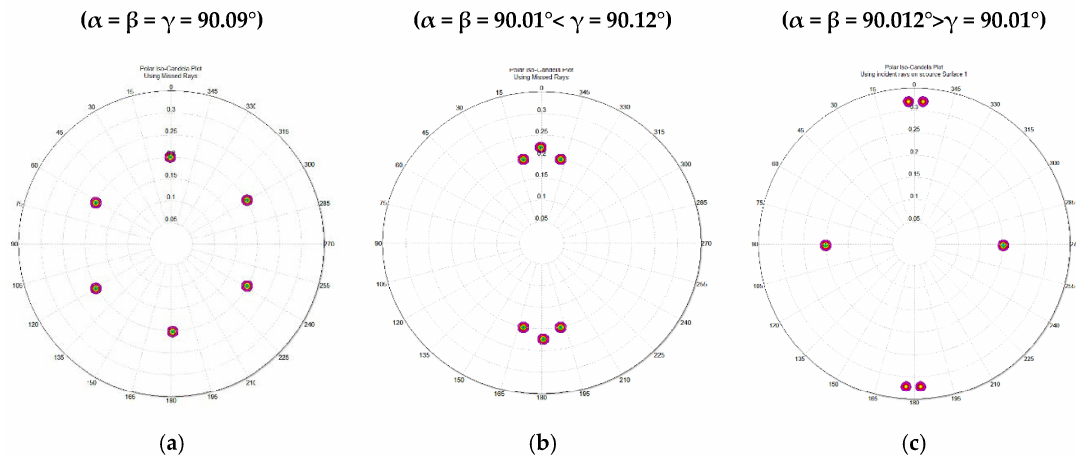
Figure 4. Relationship between dihedral angles and the reflected beam direction. ( a ) The reflected intensity distribution by a regular retro-reflector. ( b ) The reflected intensity distribution by a SuperPin retro-reflector. ( c ) The reflected intensity distribution by a SuperPin Plus retro-reflector.